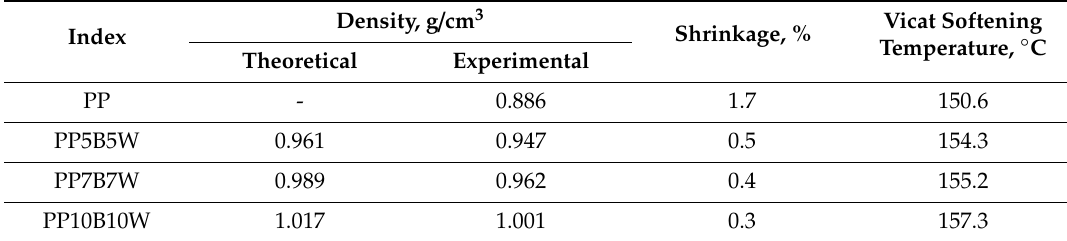
Table 2. Basic physical and processing properties of the